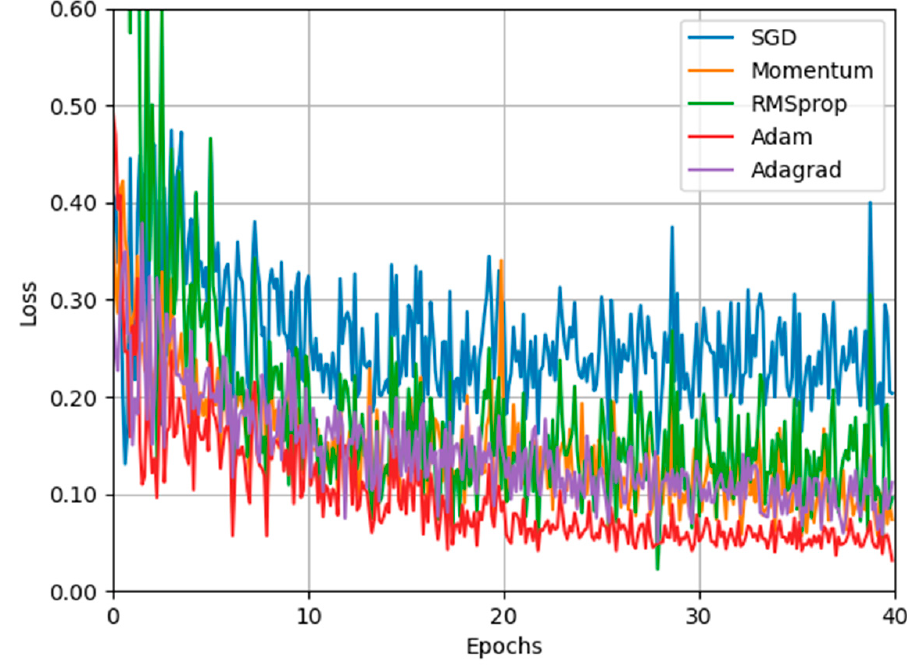
Figure 12. Convergence curves for different optimizers.